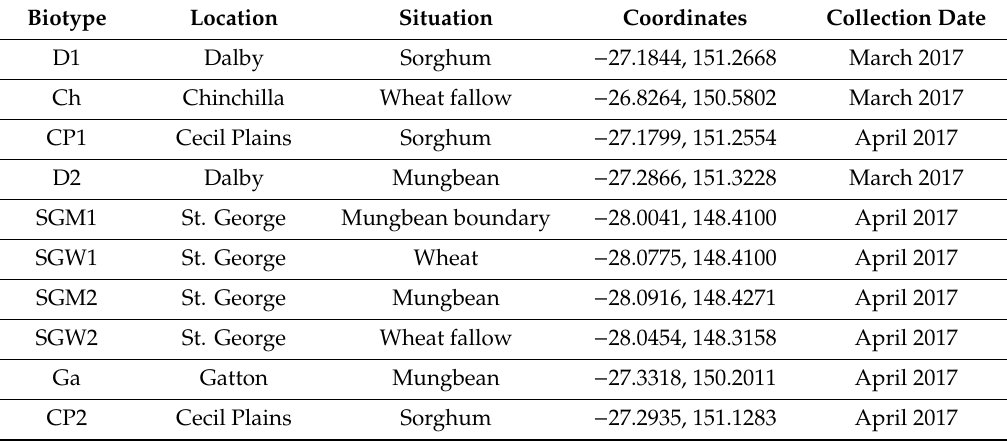
Table 1. Biotypes collected from di ff erent regions of Queensland,